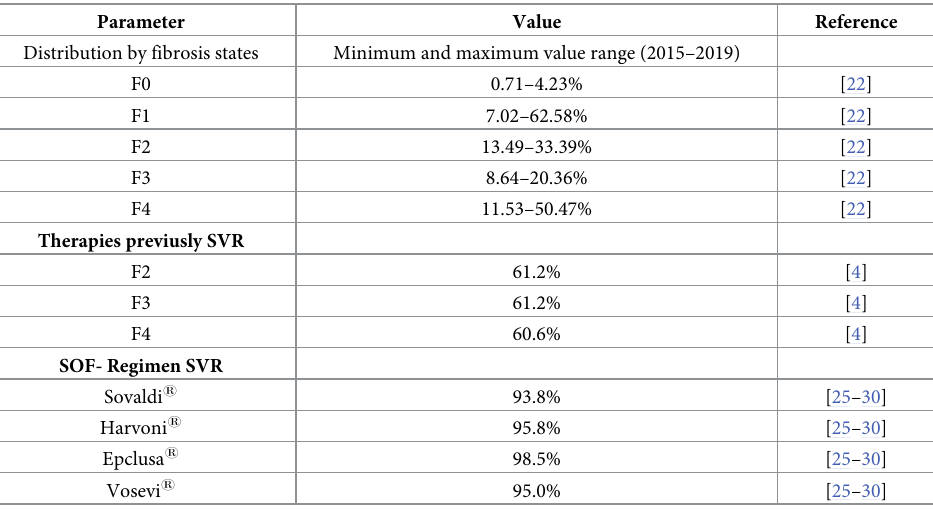
Table 1. Analysis